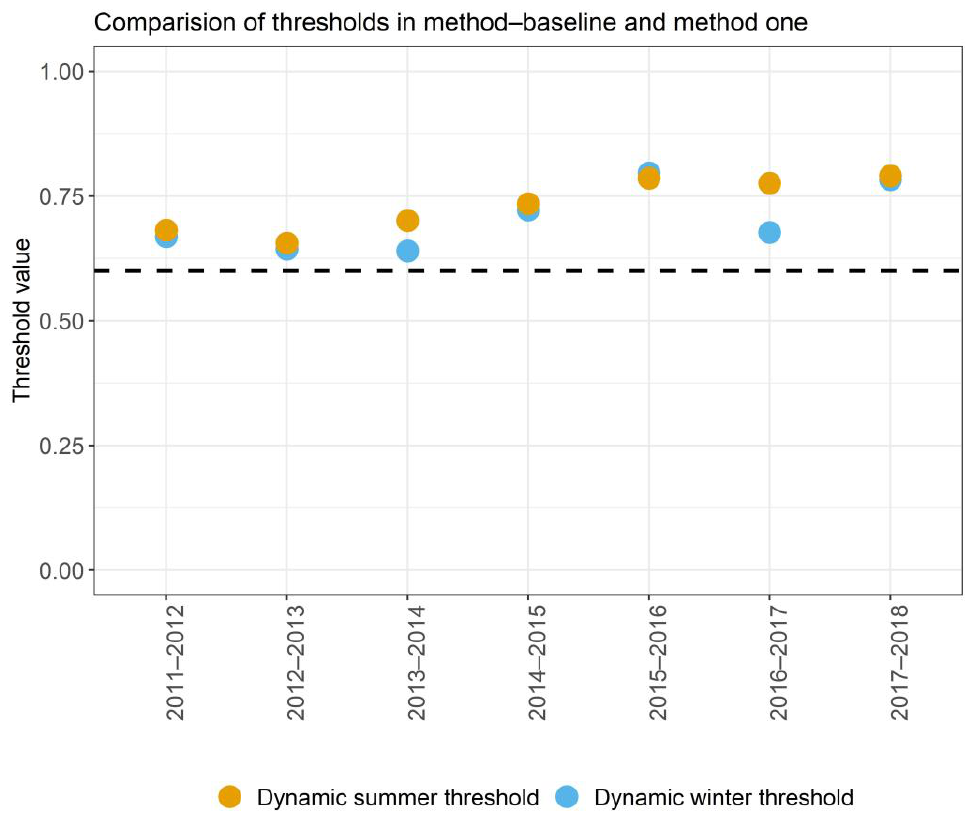
Figure 8. Method validation accuracies for winter and summer irrigated field classification, respectively.